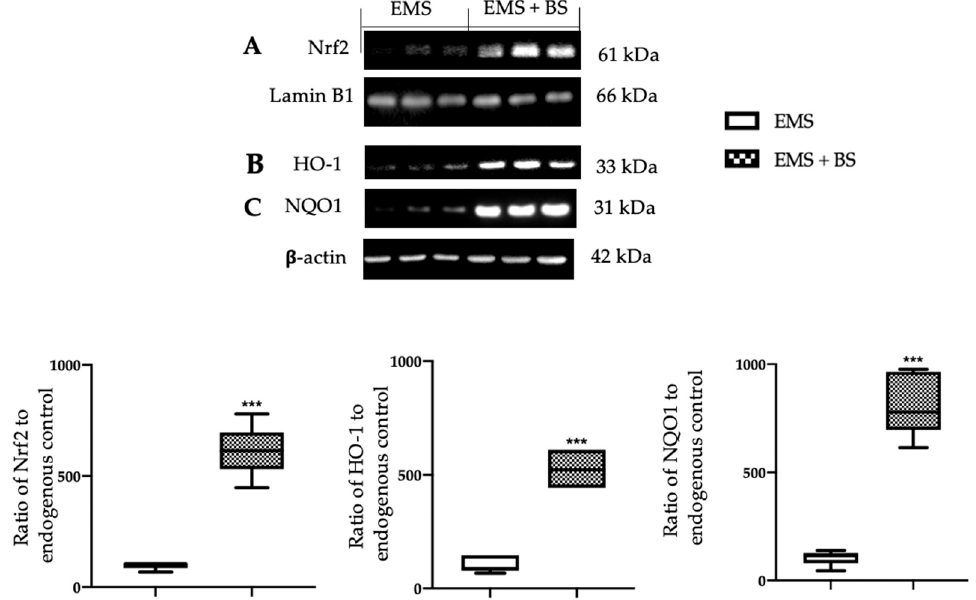
Figure 3. Analysis of the effect of oral BS administration on Nrf2 pathway: Western blot analysis of: Nrf2 ( A ), HO-1 ( B ), NQO-1 ( C ) expression; for the analyses, n = 5 animals from each group were employed. A p -value of less than 0.05 was considered significant. *** p < 0.001 vs. control.